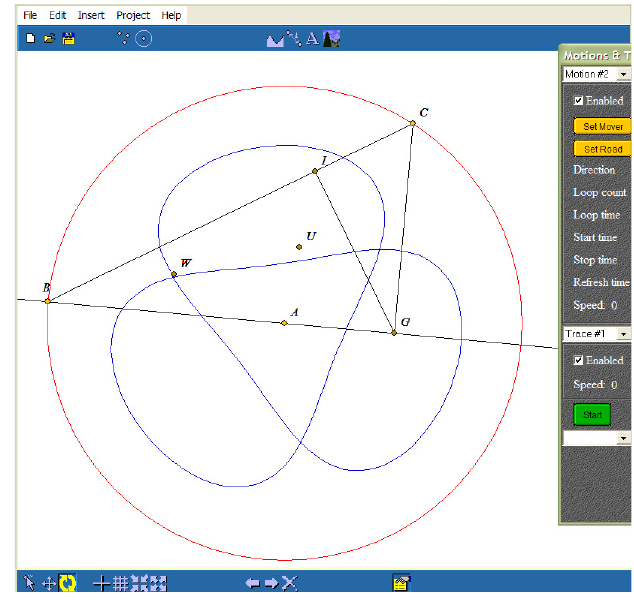
Figure 2. Trajectory of the point W (its geometrical locus)—adapted from